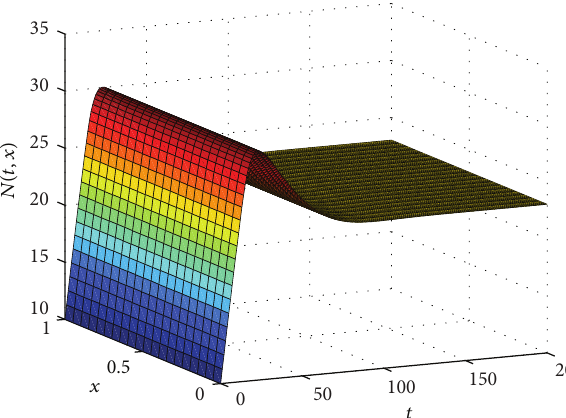
Figure 3: Parameters: 𝛿 = 0.01 , 𝑝 1 = 0.5 , 𝑝 2 = 0.5 , 𝑎 = 0.2 , 𝜏 1 = 12 , = 15 , and 𝑁 ∗ = 23.0259 . Initial condition is 𝜓(𝜃,𝑥) = 10 + sin 𝜃 , 𝜏 2 (𝜃, 𝑥) ∈ [−15,0] × [0,1] .